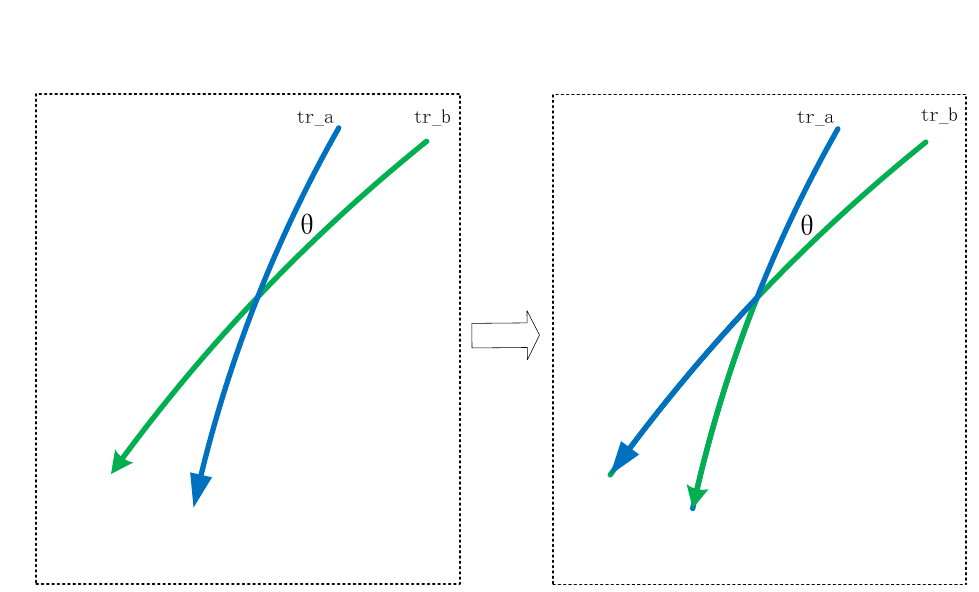
Figure 1. The process of exchanging intersecting